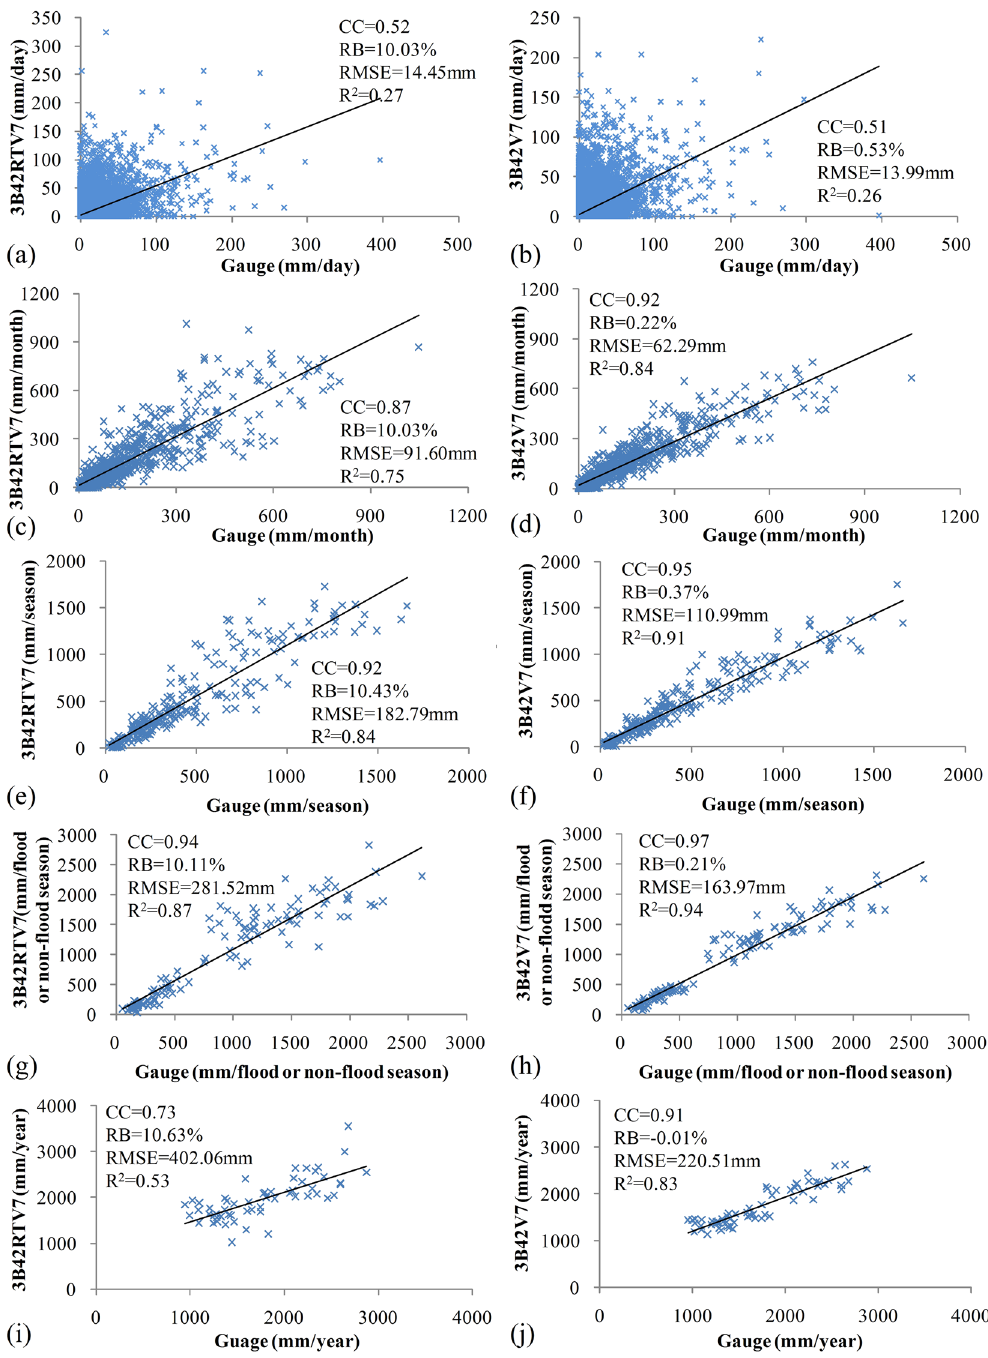
Figure 3. Scatter plots of grid-based daily, monthly, seasonal, flood seasonal or non-flood seasonal, and yearly precipitation at seven selected grid-boxes over the Nanliu river basin at relevant